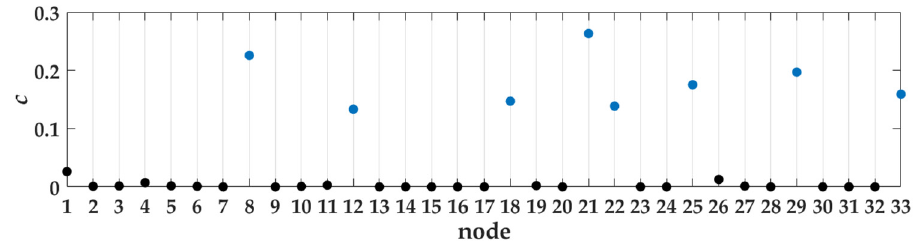
Figure 4. Decision graph with four SOPs integrated in the system. Table 2. Detailed distribution result of nodes.